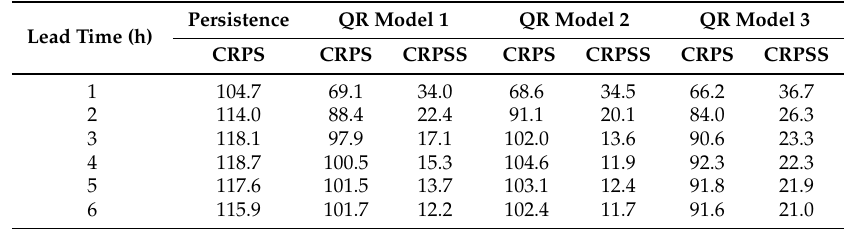
Figure 8. ( a ) Relative CRPS: site of Le Tampon; ( b ) Relative CRPS: site of Desert Rock. Table 2. CRPS and CRPS skill score (CRPSS) for the site of Le Tampon. CRPS values are in W · m − 2 . and the CRPSS is in